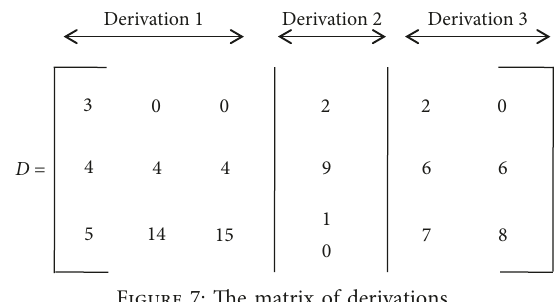
Figure 7: The matrix of derivations.